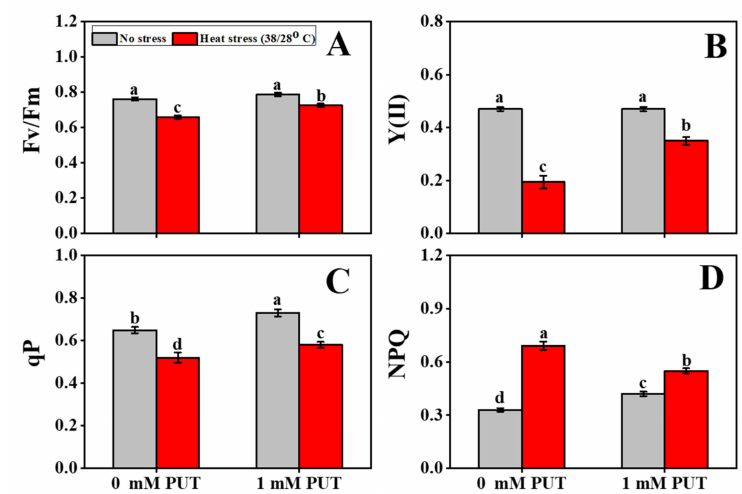
Figure 5. Interactive effects of Putrescine and high temperature on photosynthetic attributes in tomato seedlings. ( A ) Maximum quantum yield of PSII (Fv/Fm), ( B ) Effective quantum efficiency of PS II (Y(II)), ( C ) Photochemical quenching coefficient (qP), and ( D ) Non-photochemical quenching (NPQ). The data denote the mean value ± standard error (n = 3). Different alphabetic letters represent the significant differences among the treatments at p < 0.05, according to Tukey’s test.